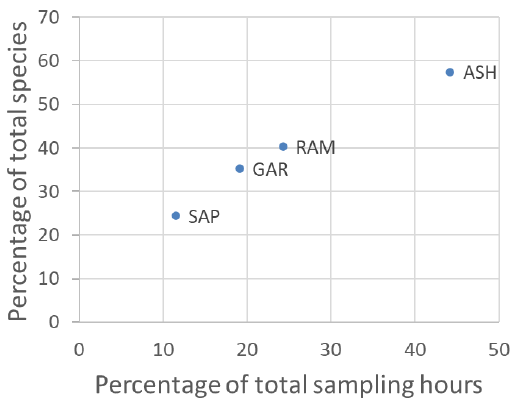
F IGURE 1. Percentage of total sampling hours (x axis) vs percentage of total species (y axis) D ISCUSSION